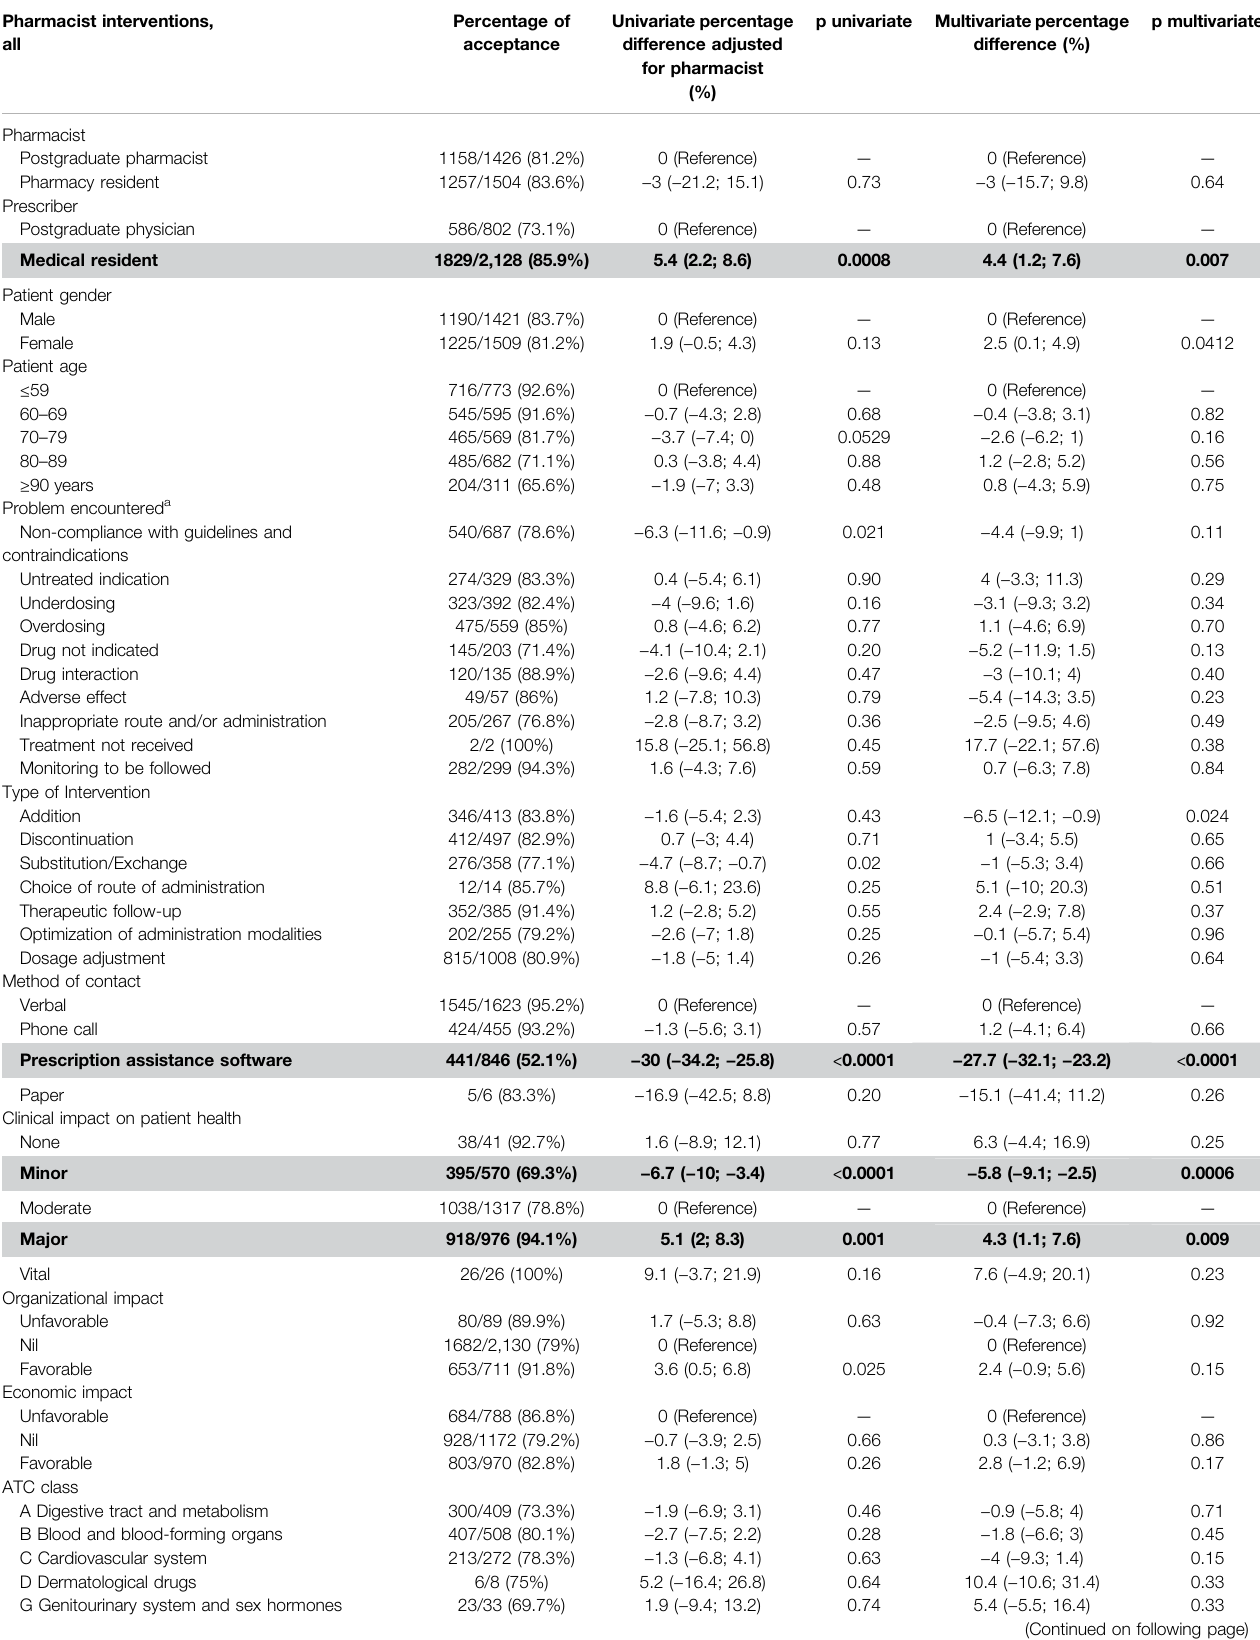
TABLE 2 | Factors for acceptance of PIs, univariate and multivariate